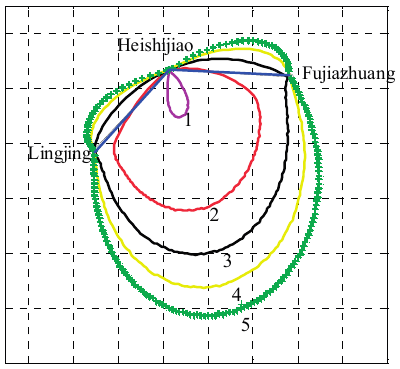
Figure 7. GDOP for the verification system of